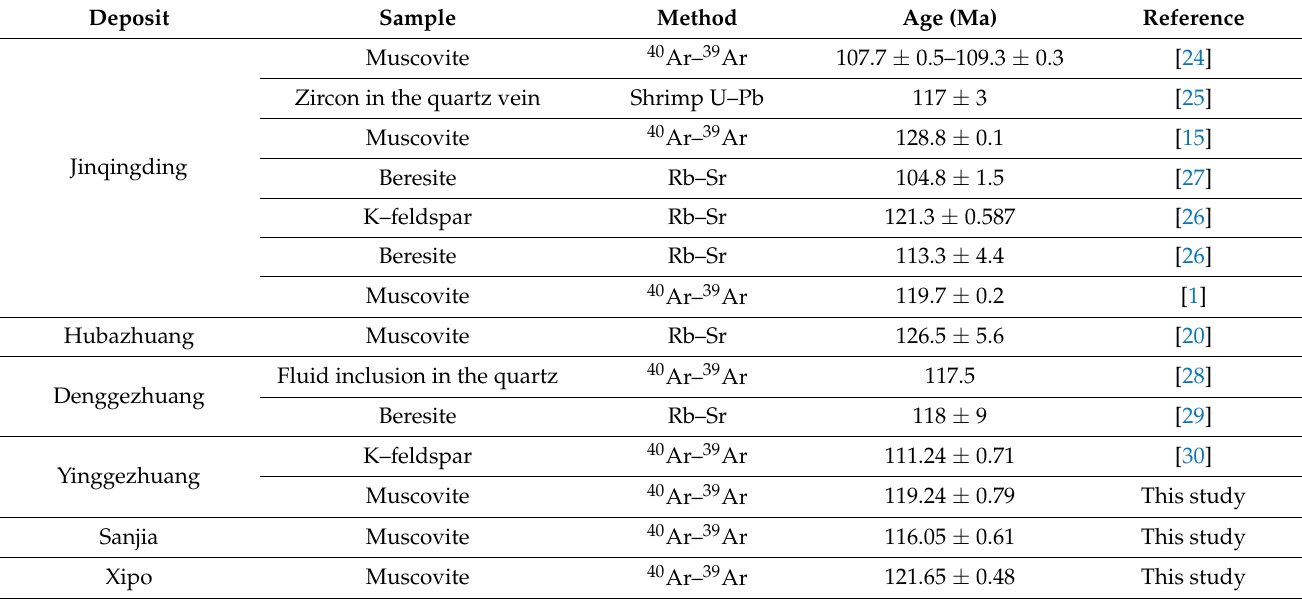
Table 2. Mineralization age in the Muping–Rushan gold